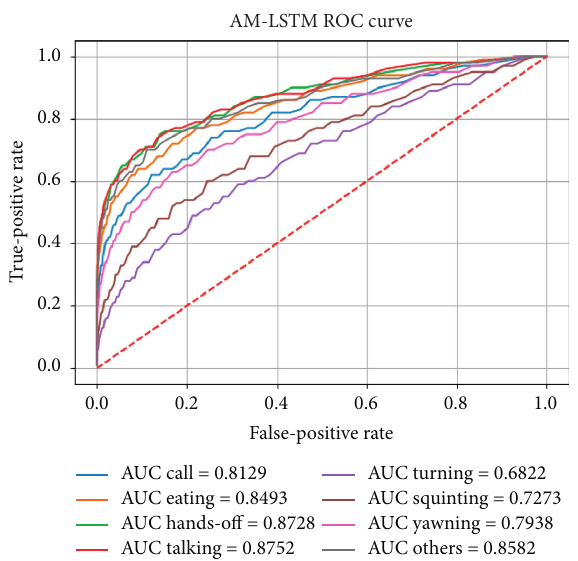
Figure 12: ROC curve of different